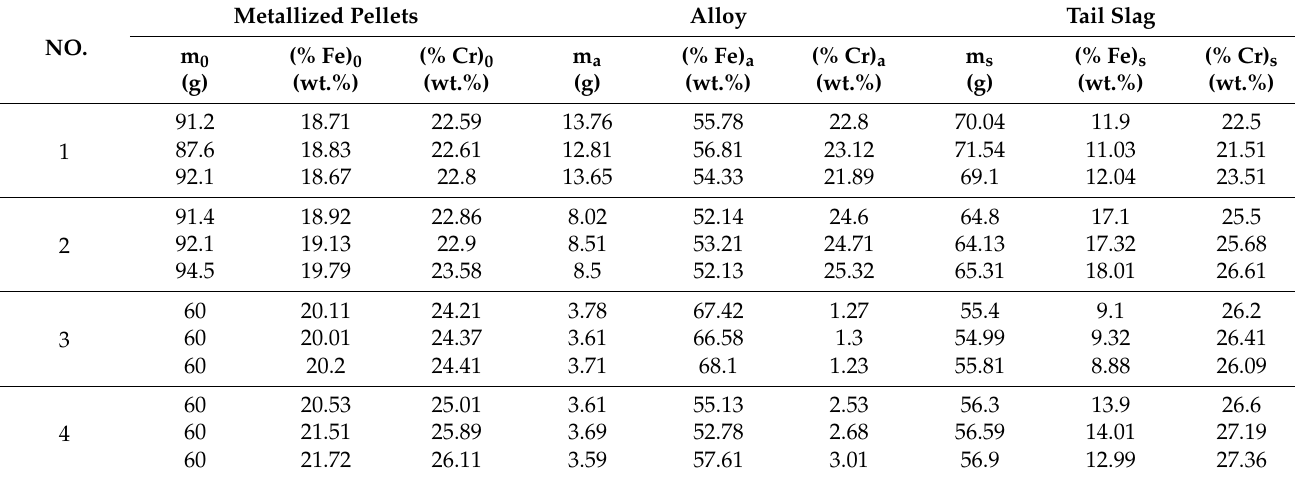
Table 4. Weight and composition of the metallized pellets, alloy, and tail